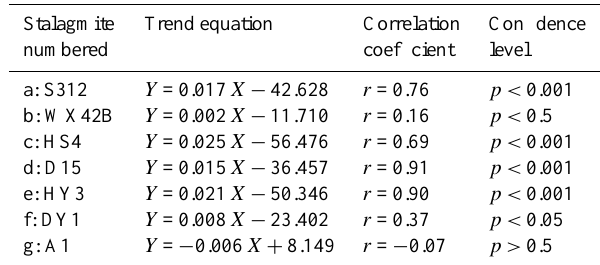
Table 1. The trend equation and correlation coefficient for the δ 18 O cs